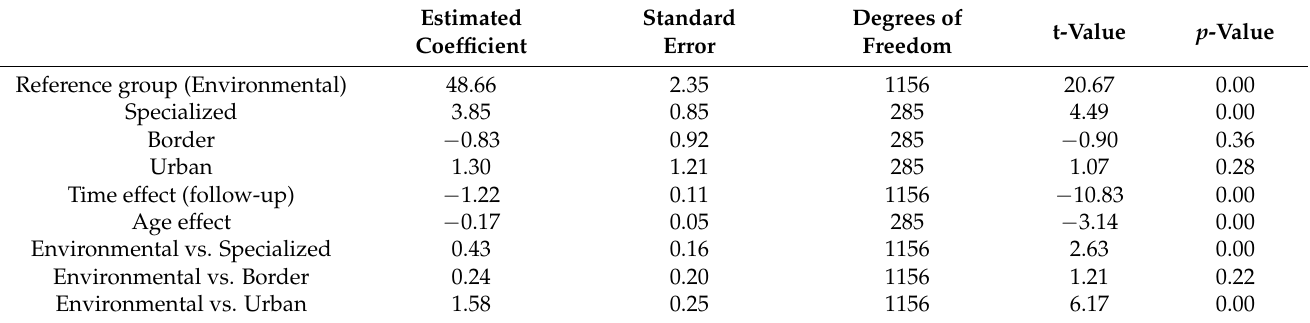
Figure 3. VO 2 max behavior of police officers over the years. ( A ): Changes in VO 2 max performance over 5 years according to police specialties; ( B ): VO 2 max performance achieved by police officers in relation to age; ( C ): Comparison of VO 2 max achieved between police specialties at baseline (gray color indicates significant difference between the respective groups). Table 3. Statistical summary and model-estimated coefficients of the effect of group, time, and age on VO2max performance.